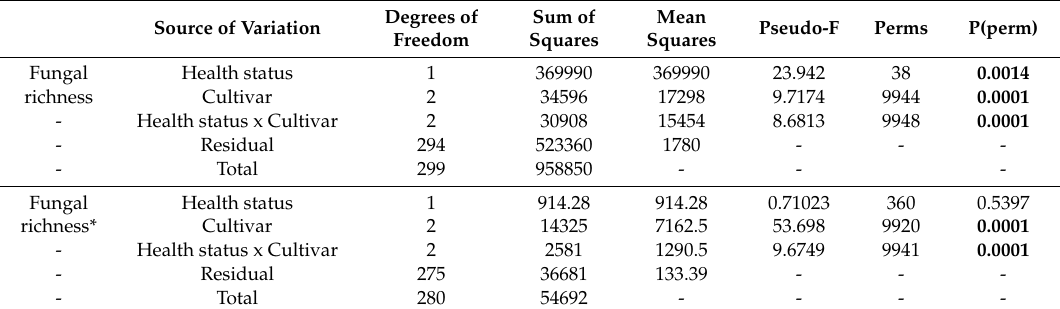
Figure 1. Mean fungal richness ± standard error (SE) at each: health status (asymptomatic and symptomatic) and cultivar (‘Galega vulgar’, ‘Cobrançosa’ and ‘Picual’). Di ff erent letters indicate significant di ff erences (p < 0.05) and equal letters indicate no significant di ff erences (p > 0.05). Lowercase letters indicate comparisons between cultivars (‘Galega vulgar’, ‘Cobrançosa’, and ‘Picual’) within each Health status (asymptomatic or symptomatic). Capital letters indicate comparisons between the same cultivar (‘Galega vulgar’, ‘Cobrançosa’, and ‘Picual’) in the di ff erent Health status (Asymptomatic and Symptomatic). ( I ) represents fungal richness dataset and ( II ) represents fungal richness dataset excluding both pathogenic fungi V. oleaginea and P. cladosporioides . Table 2. Details of the two-factor PERMANOVA test on the fungal dataset for the factors; “Health status” Asymptomatic and Symptomatic (2 levels, fixed) and “Cultivar” ‘Galega vulgar’, ‘Cobrançosa’ and ‘Picual’ (3 levels, random) for all variables analyzed. Bold values highlight significant e ff ects and interactions (p <